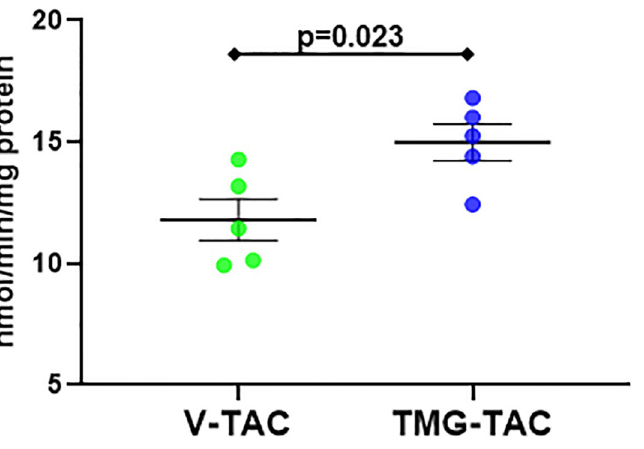
Fig 5. Quantification of enzyme activity for CPT1 in experimental groups V-TAC versus TMG-TAC. Activity is defined as nmol CoA-SH released/min/mg protein. Bars indicate mean ± standard error of the mean. N = 5 per group.